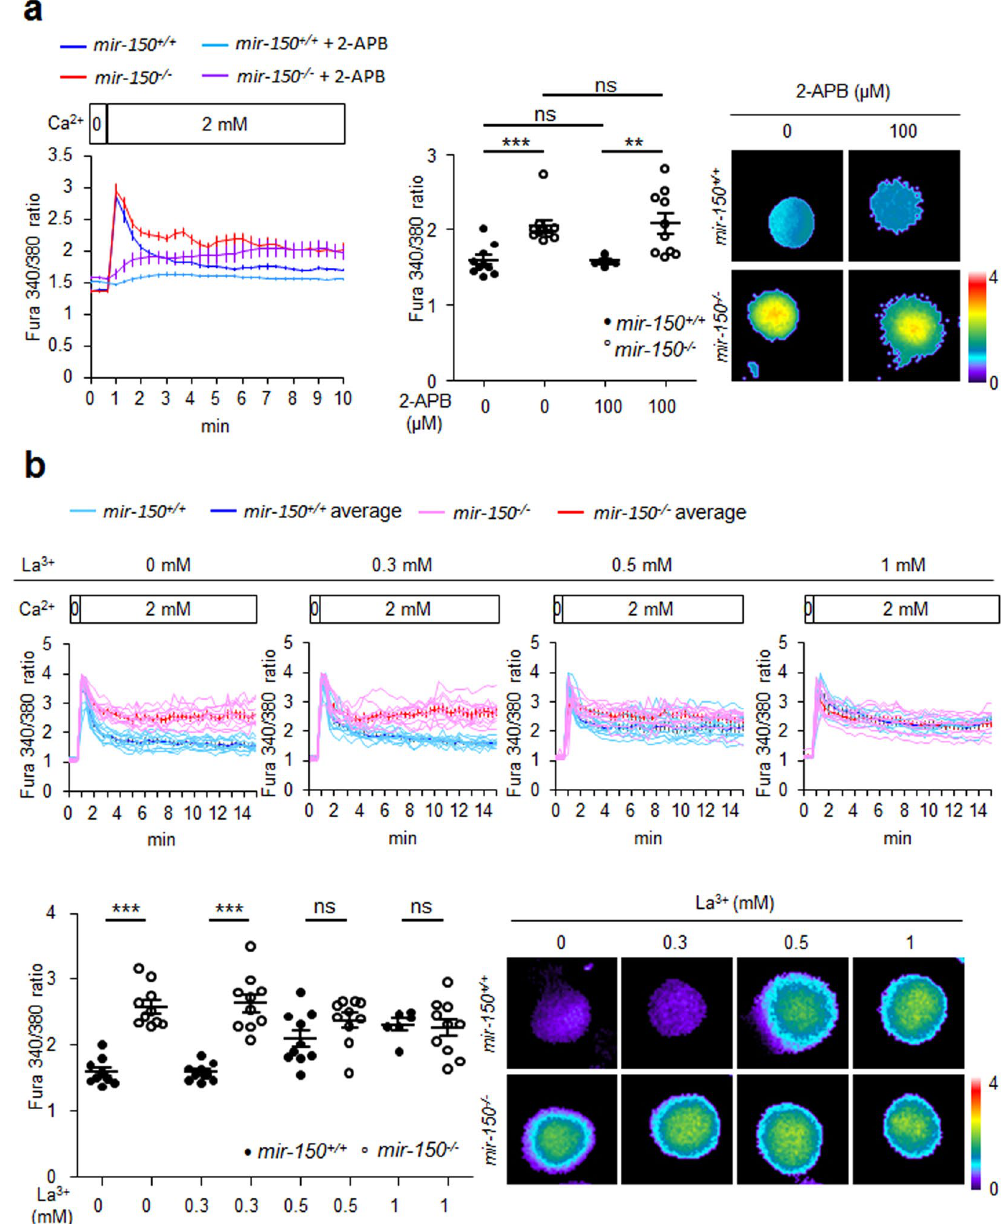
Figure 4. Elevated intracellular Ca 2 + levels in miR-150 deficient CD8 + T cells are caused by down-related PMCA activity. ( a ) Intracellular Ca 2 + levels in mir-150 + / + or mir-150 − / − naïve CD8 + T cells in the presence or absence of CRAC inhibitor (2-Aminoethoxydiphenyl borate, 2-APB) (left) and the intracellular Ca 2 + levels at 10 min incubation (middle). Images are the representatives at 10 min incubation (right). mir-150 + / + or mir- 150 − / − naïve CD8 + T cells were incubated in 2 mM of Ca 2 + containing medium in the presence or absence of 2-APB for 10 min and measured the intracellular Ca 2 + levels from the cells. ( b ) Change in the intracellular Ca 2 + level by treatment with PMCA inhibitor, La 3 + (0.3, 0.5 or 1 mM), in mir-150 + / + and mir-150 − / − naïve CD8 + T cells. mir-150 + / + and mir-150 − / − naïve CD8 + T cells were cultures with 2 mM of Ca 2 + containing medium and incubated in the presence or absence of indicated concentration of La 3 + (up). Dot graph shows intracellular Ca 2 + level at 15 min incubation (down left). Images are representatives for the intracellular Ca 2 + level from the CD8 + T cells at 15 min incubation (down right). ** P < 0.01, *** P < 0.001, ns: not significant. Data are means ± SEM of duplicate triplicate samples from a single experiment and are representative of two independent